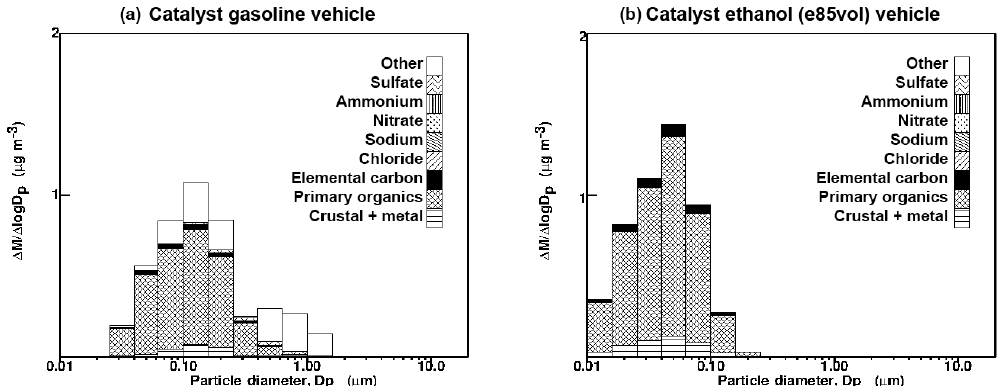
Figure 5. Particle emissions size and composition distribution for catalyst-equipped gasoline vehicles (a) and catalyst-equipped ethanol (E85) vehicles (b)